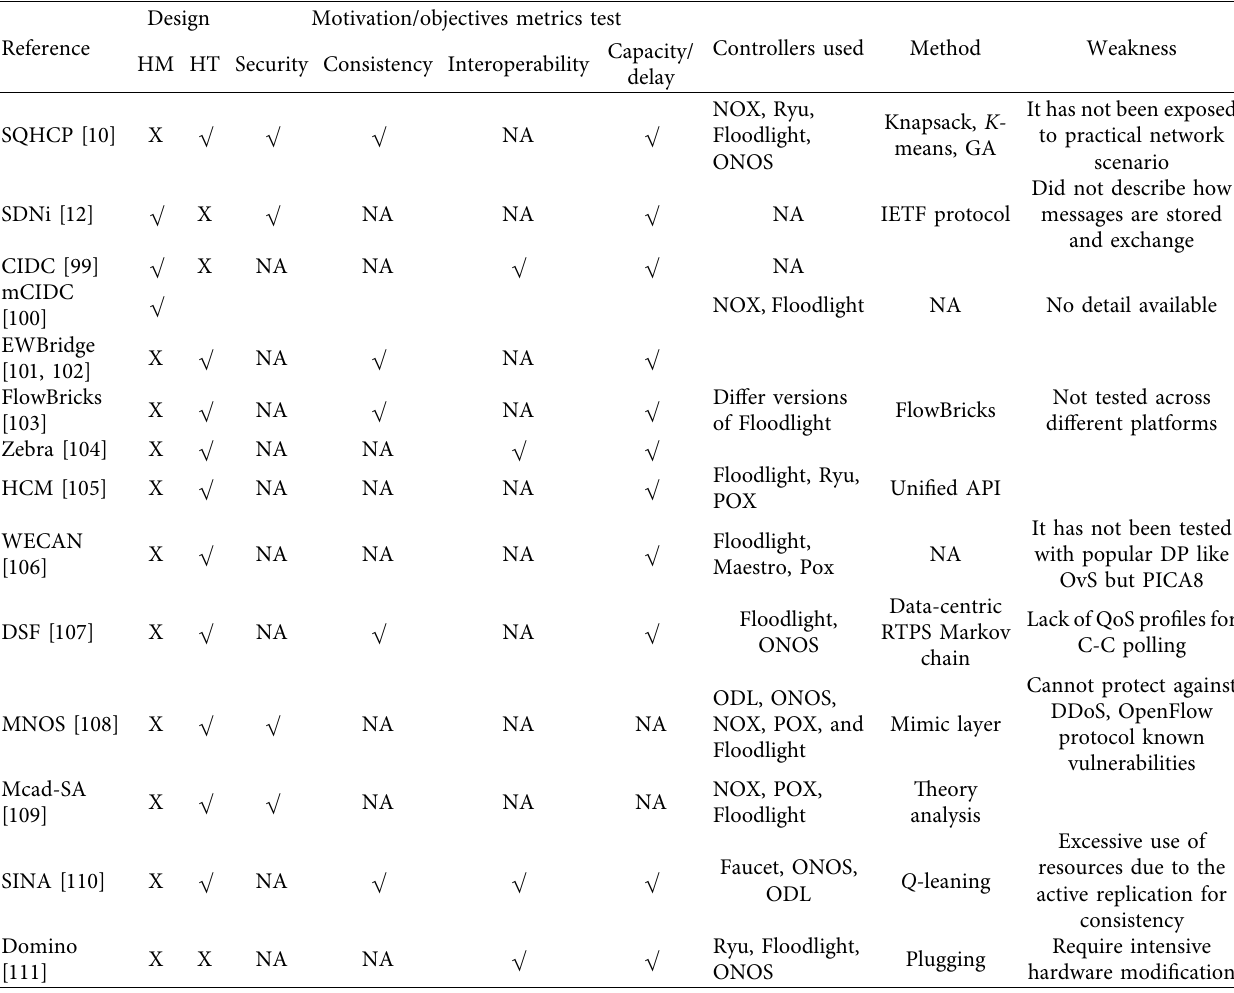
Table 5: Comparison of controller interoperability.